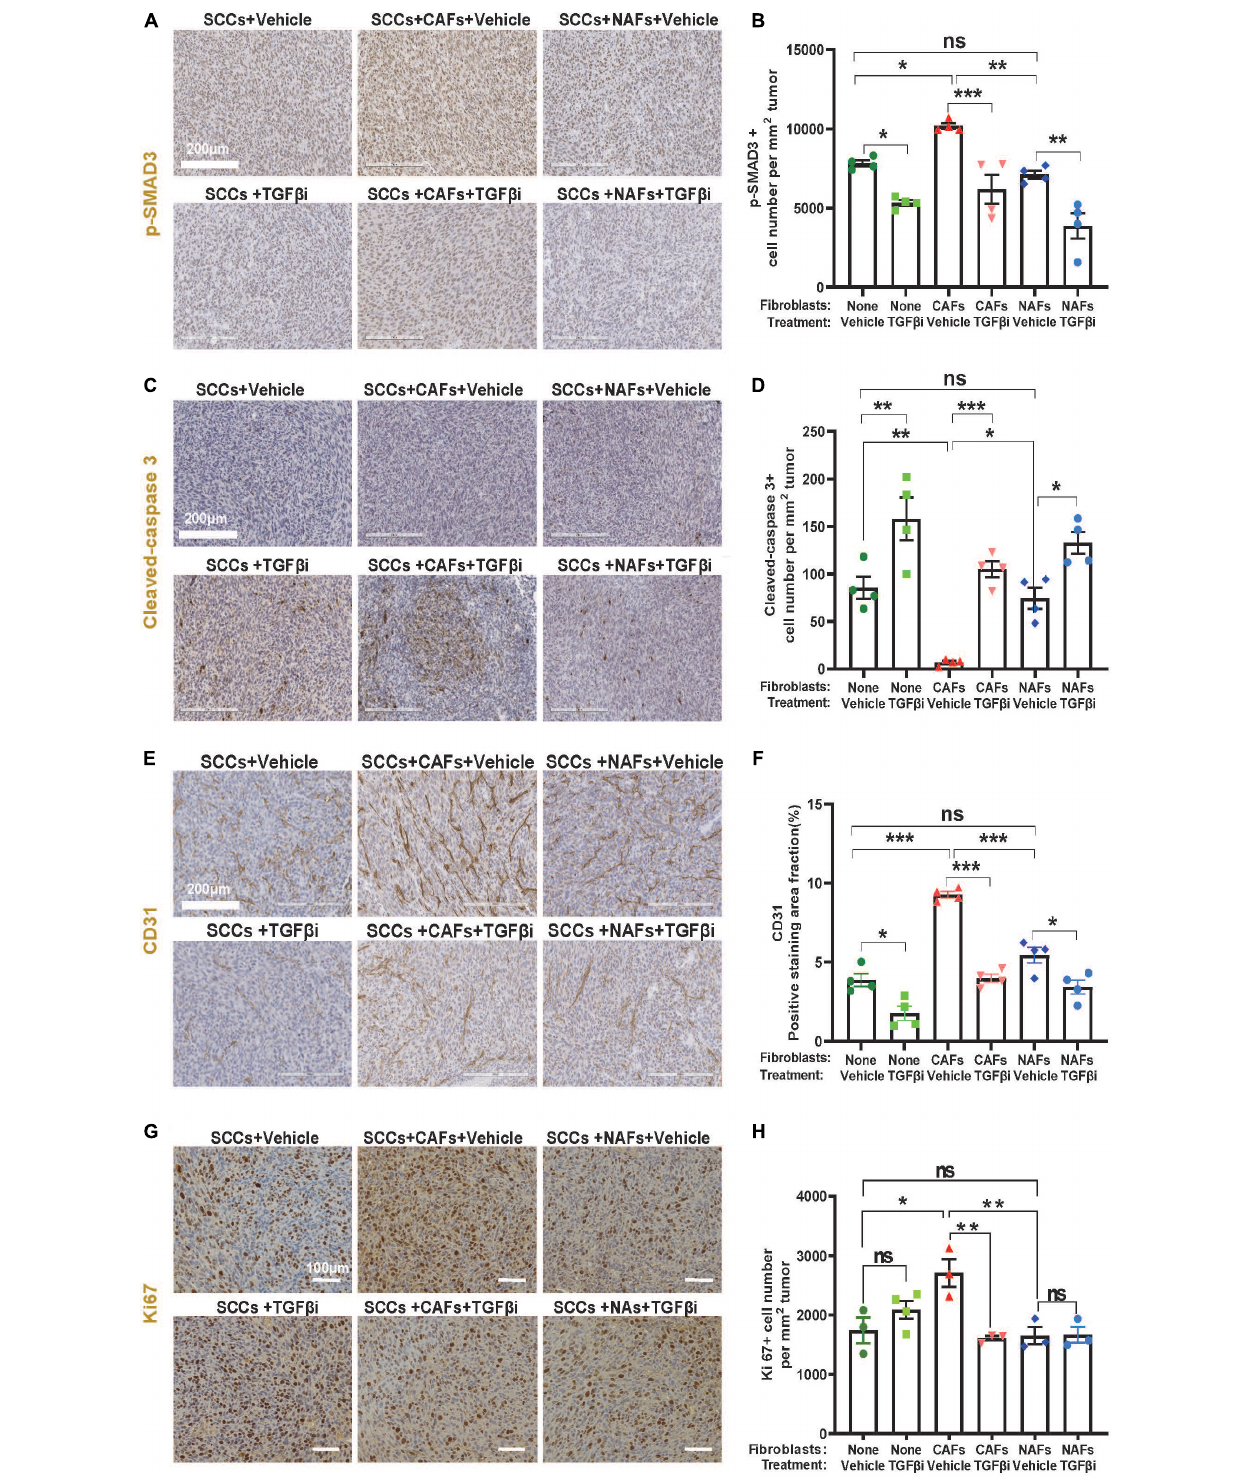
FIGURE 3 | Increased proliferation and angiogenesis and decreased apoptosis in CAF-co-transplanted, lung-seeded tumors is attenuated by TGF β inhibition. (A,B) Representative p-SMAD3 IHC stained images and quantification in lung-seeded A223 tumors. Scale bar: 200 µ m. (C,D) Representative cleaved-caspase 3 IHC stained images and quantification in lung-seeded A223 tumors. Scale bar: 200 µ m. (E,F) Representative CD31 IHC stained images and quantification in lung-seeded A223 tumors. Scale bar: 200 µ m. (G,H) Representative Ki67 IHC stained images and quantification in lung-seeded A223 tumors. Scale bar: 100 µ m. ns P > 0.05, * P < 0.05, ** P < 0.01, *** P <